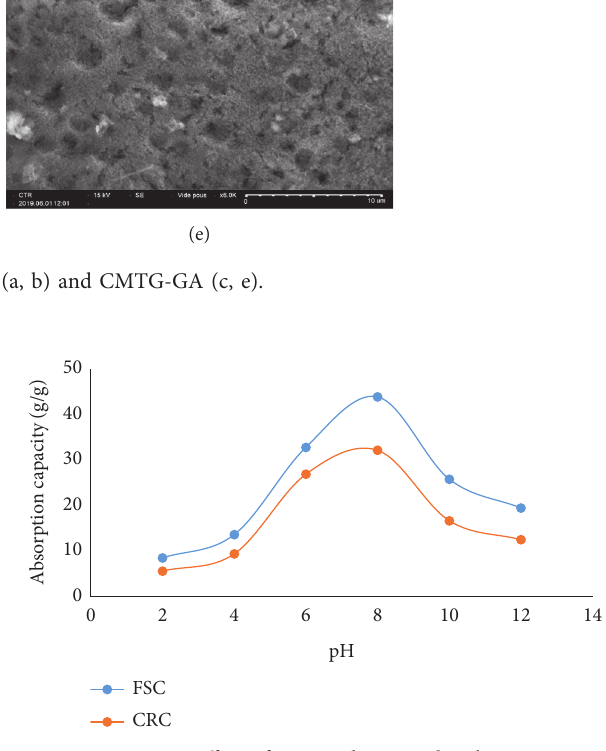
Figure 8: Effect of the crosslinking agent amount on the SAP absorbency.